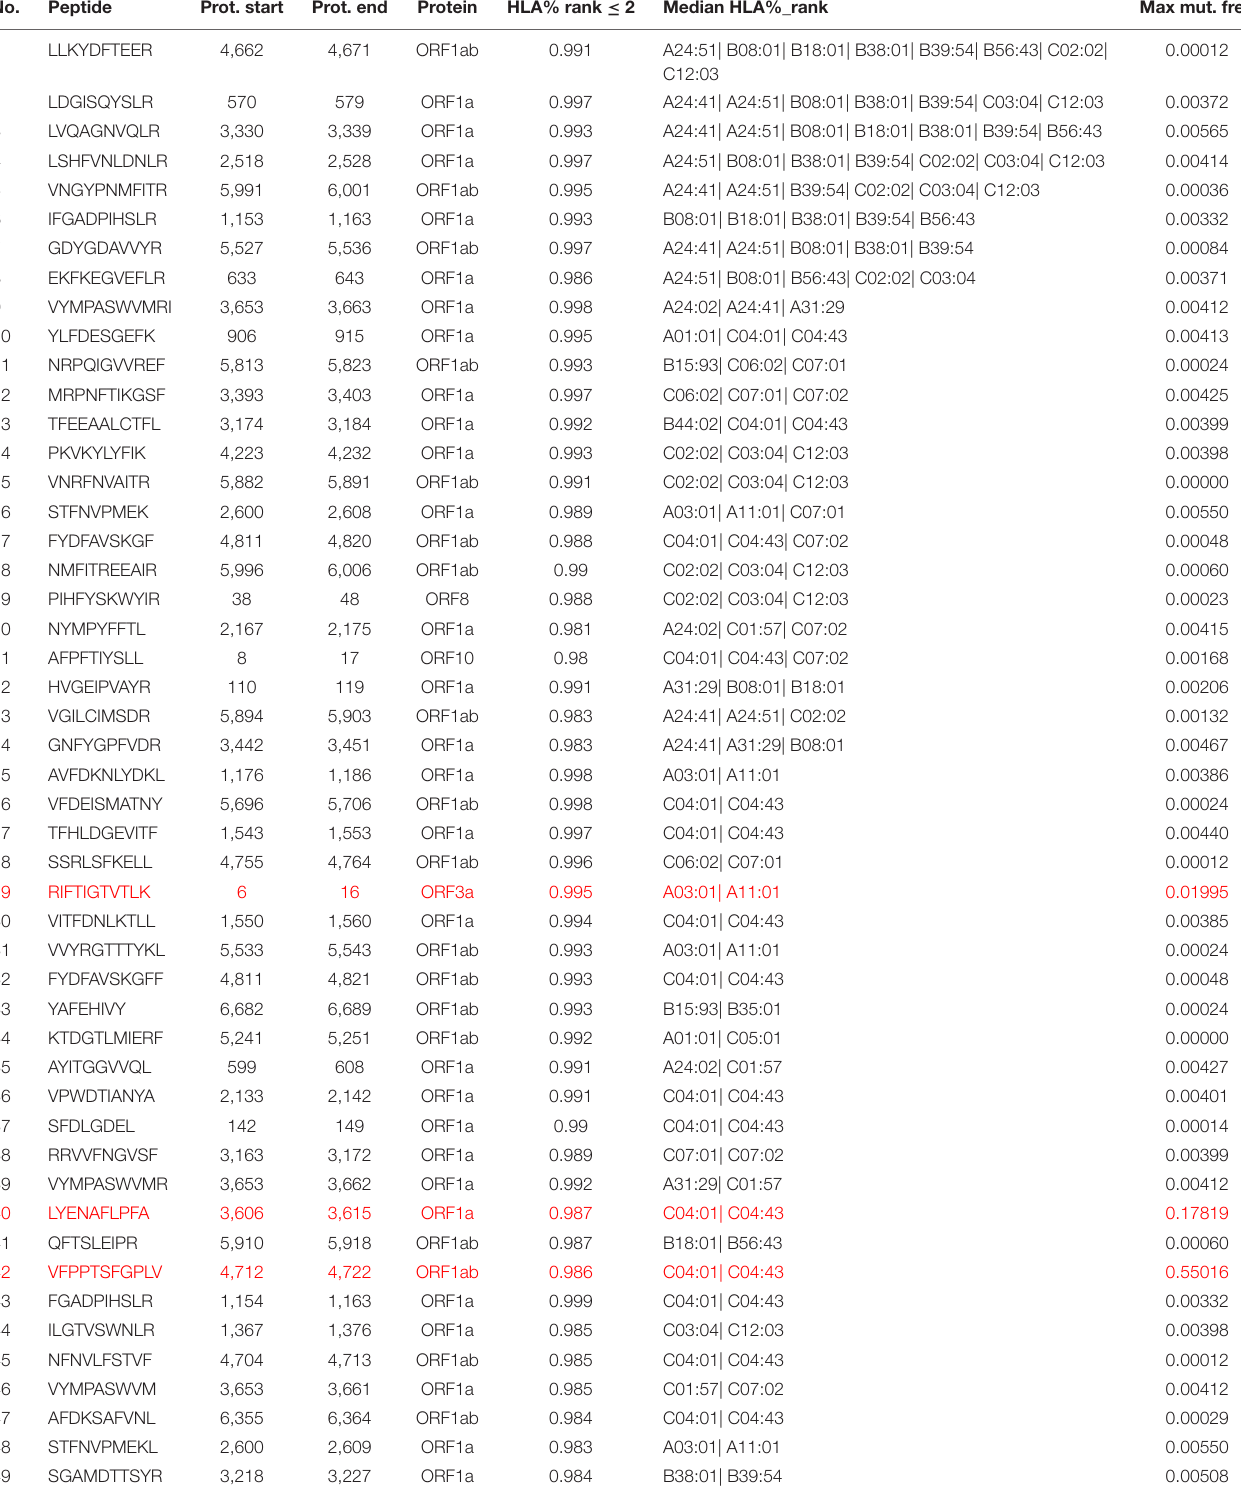
TABLE 4 | Peptides with model percentile rank ≤ 2 obtained from SARS-CoV-2 non-structural proteins, sorted by (1) the number of HLA types capable of binding and presenting given peptide and (2) the median rank across different HLA types. No.